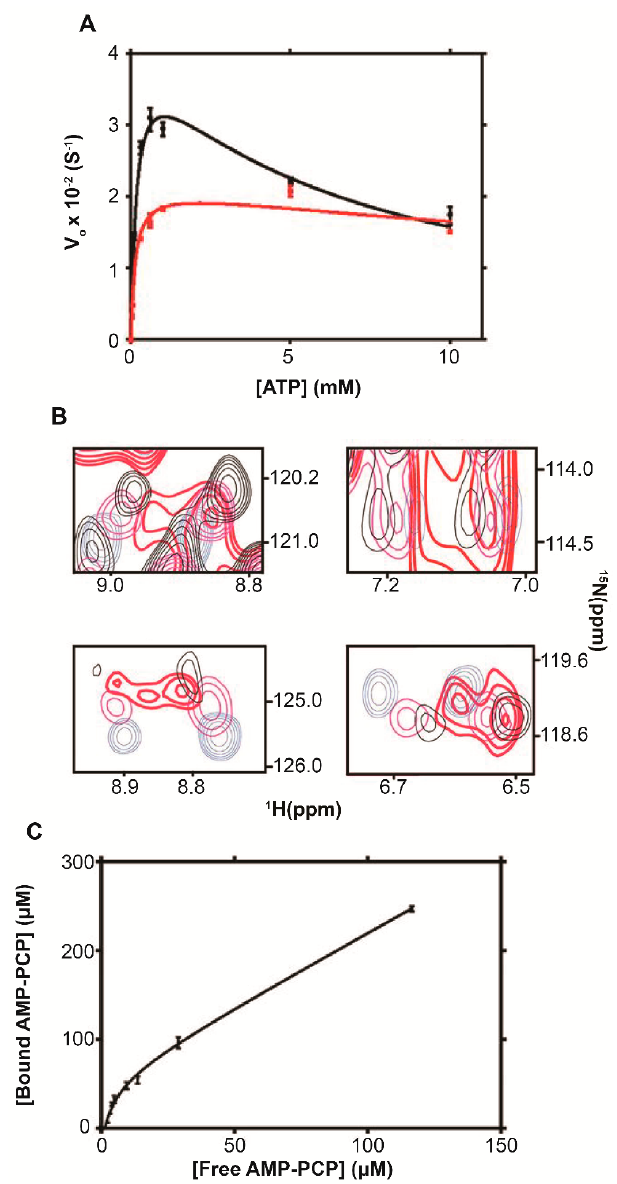
Figure 9. Ribosomes modulate ADK enzymatic activity. ( A ) Kinetic activity profile for ADK without (black) and with (red) 1 µM ribosome. ( B ) Overlays of in vitro 1 H- 15 N CRINEPT–HMQC–TROSY spectra of 10 µM [ U - 2 H, 15 N] ADK at 0 µM adenosine triphosphate, ATP, (blue), 20 µM ATP (magenta), 40 µM ATP (black), and 80 µM ATP plus 1 µM ribosome (red). ( C ) ATP analogue β , γ -methyleneadenosine 5 ′ -triphosphate, AMP-PCP binding to ribosomes. The concentration of ribosomes was 2 µM. The figure is adapted from DeMott et al . (2017) [26].